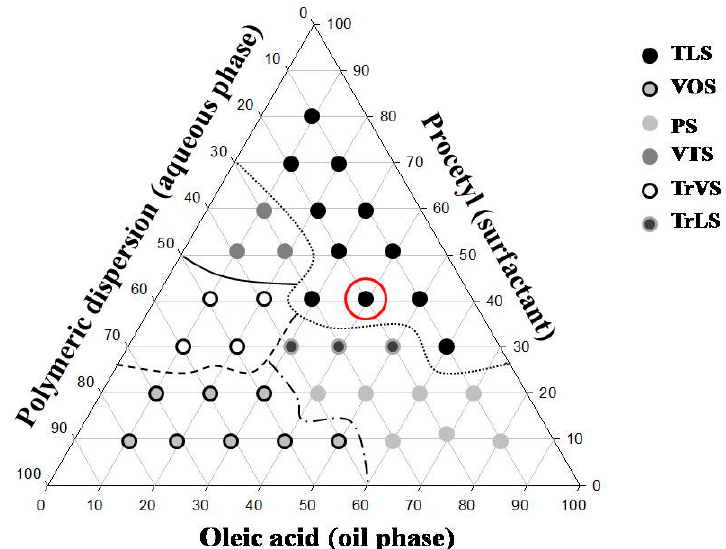
Figure 1. Ternary phase diagram with procetyl, oleic acid, and polymeric dispersion. The dashed lines represent the different regions of the diagram. The formulation S (chosen for to study) is highlighted in red. TLS = Transparent Liquid System; TrLS = Translucent Liquid System; TrVS = Translucent Viscous System; VOS = Viscous and Opaque System; PS = Phase Separation; VTS = Viscous Transparent System.